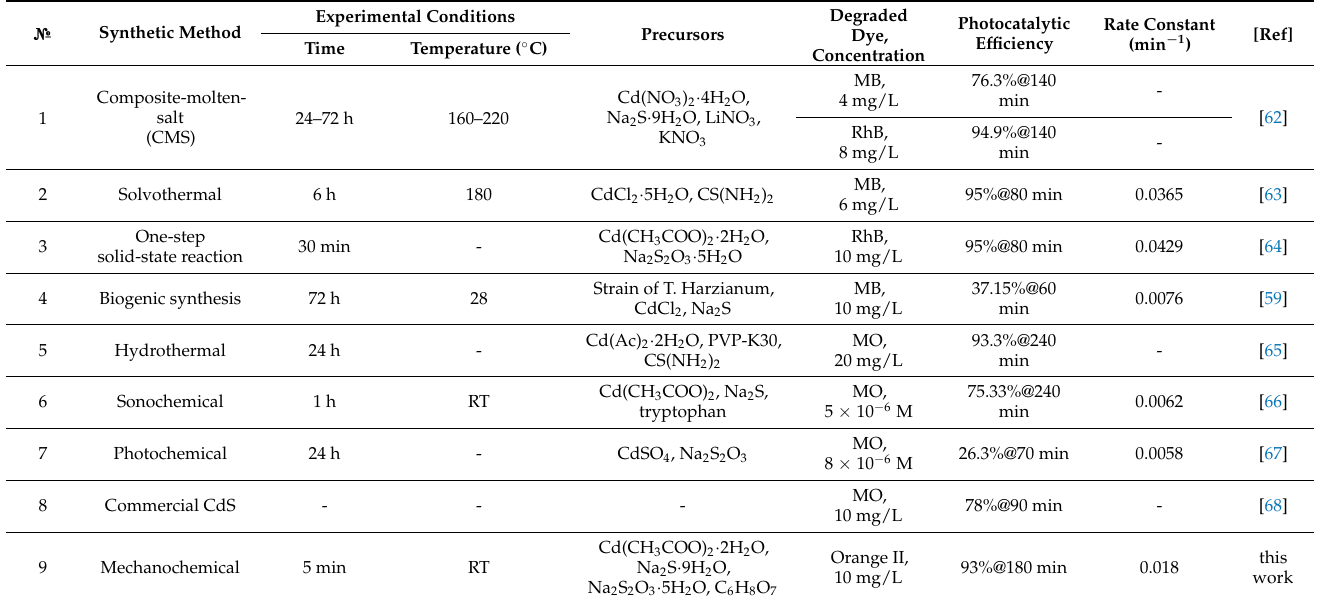
Table 2. Comparison of photocatalytic activities of CdS nanoparticles with other